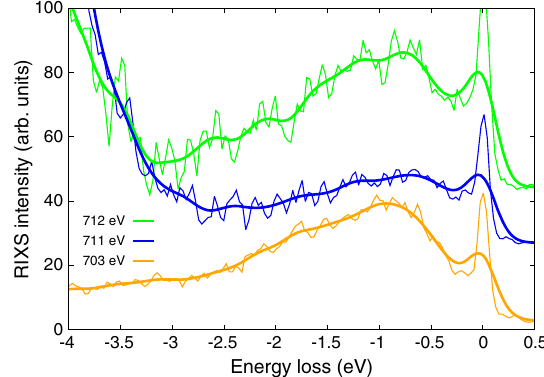
FIG. 10. Comparison of the excitonic peak in measured RIXS loss profiles of BaFe 2 As 2 for incident photon energies below and above the absorption edge. The spectra are offset and smoothed (heavy lines) for better visualization. A linear fluorescence background is subtracted from the above-threshold curves.